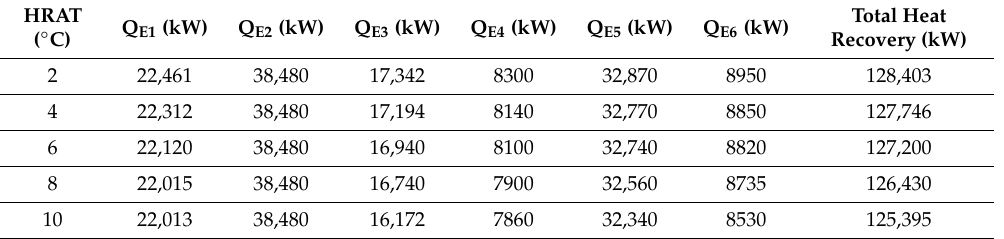
Table A6. Exchangers heat duties for HEN at di ff erent HRAT values using option